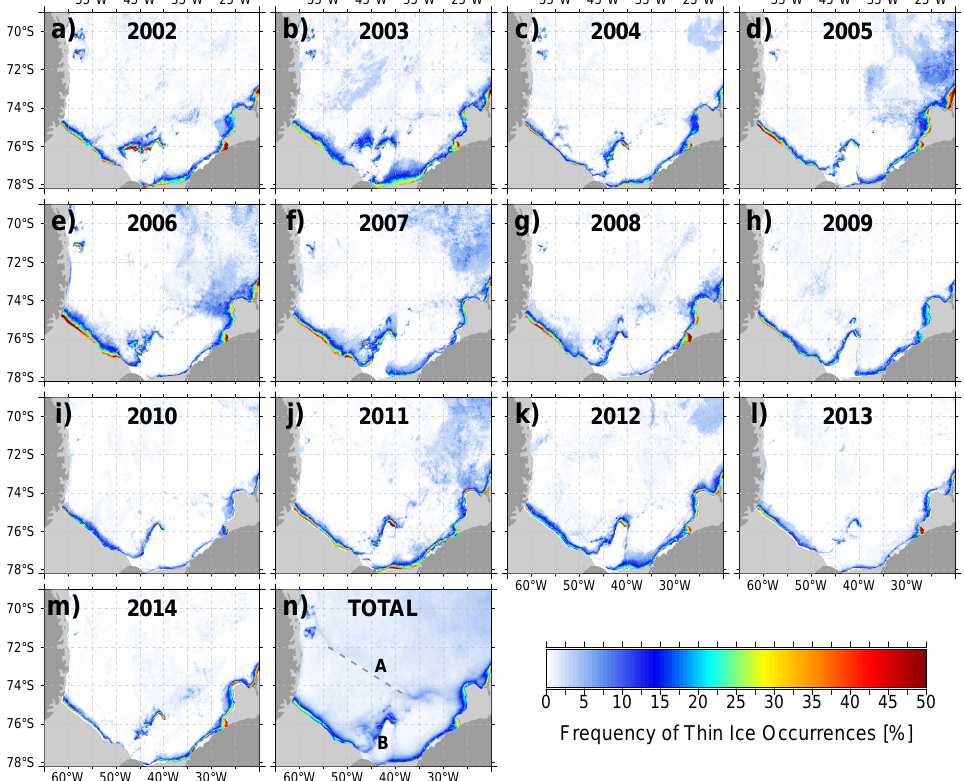
Figure 5. Frequency distribution of thin-ice occurrences in percent for the years 2002 to 2014 (a–m) as well as the overall frequency distribution (n) . Shown is the amount of days with thin-ice signal relative to the total number of clear-sky days. The added marks A and B in (n) correspond to regional features and are further described in the